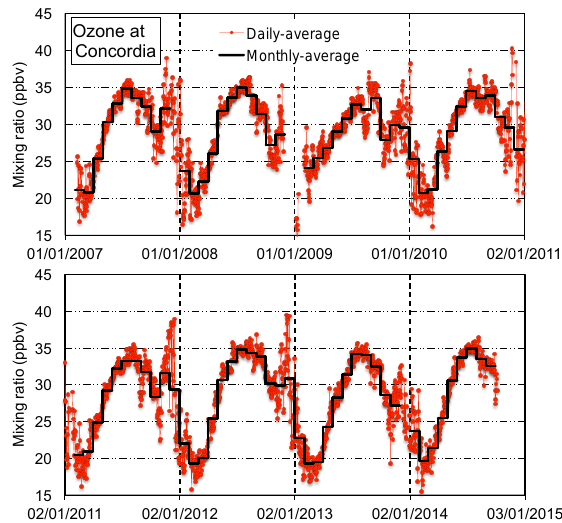
Figure 2. Daily averaged (red points) and monthly averaged (solid black line) surface ozone mixing ratio at Concordia from Febru- ary 2007 to October 2014.